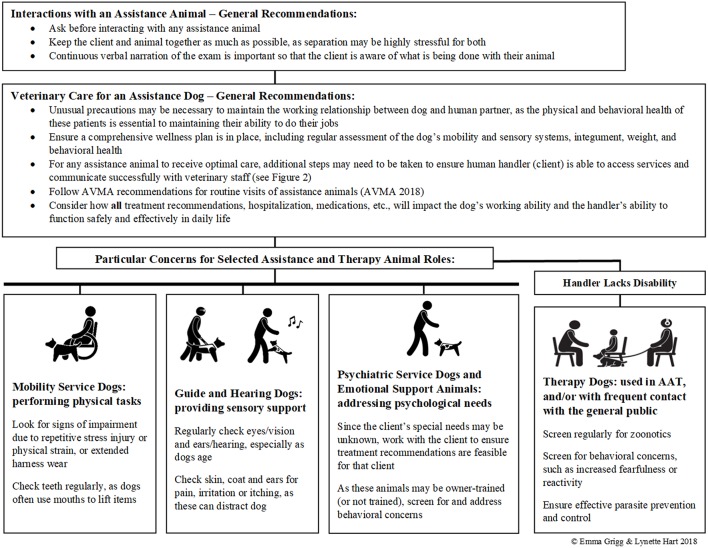
Brief recommendations for assistance and therapy animals as veterinary patients. Detailed recommendations and references are provided in the text (©Emma Grigg & Lynette Hart 2018).